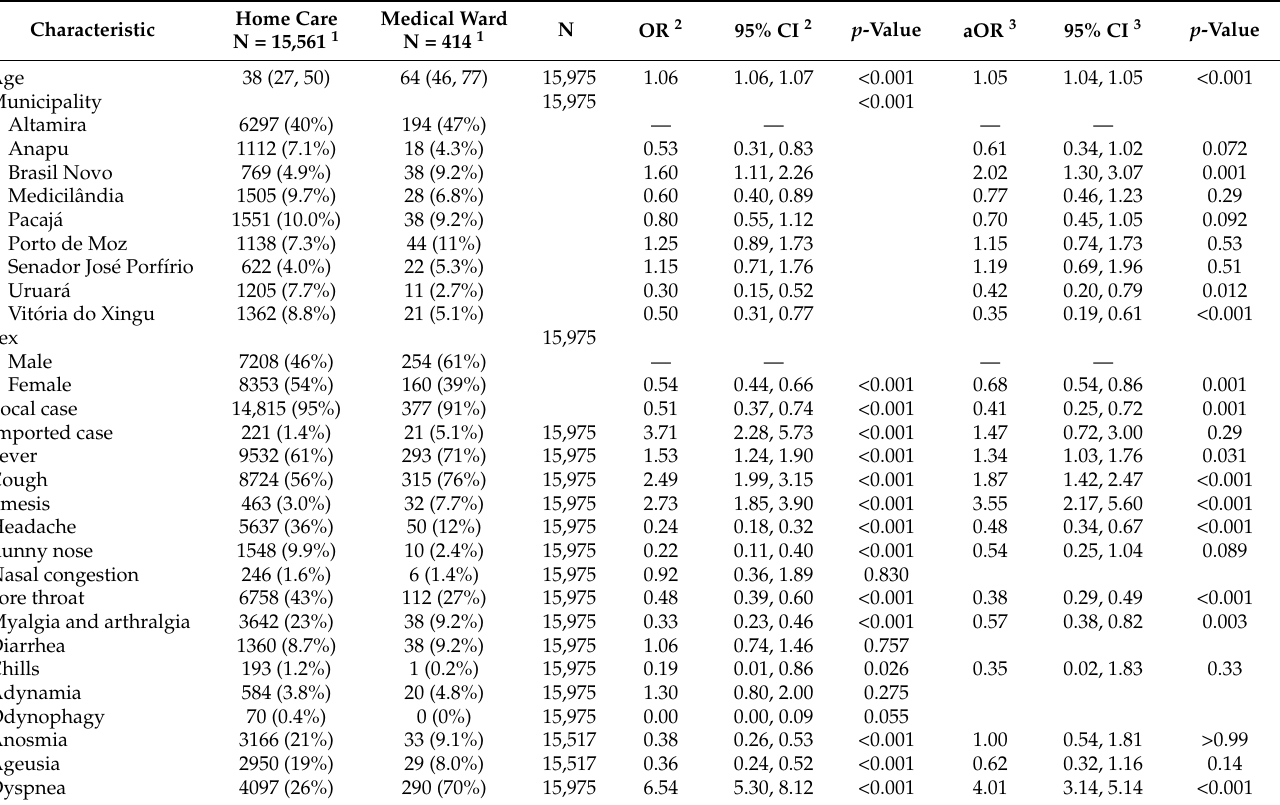
Table 2. Sociodemographic factors, symptoms and comorbidities as predictors of admission to a medical ward in relation to home